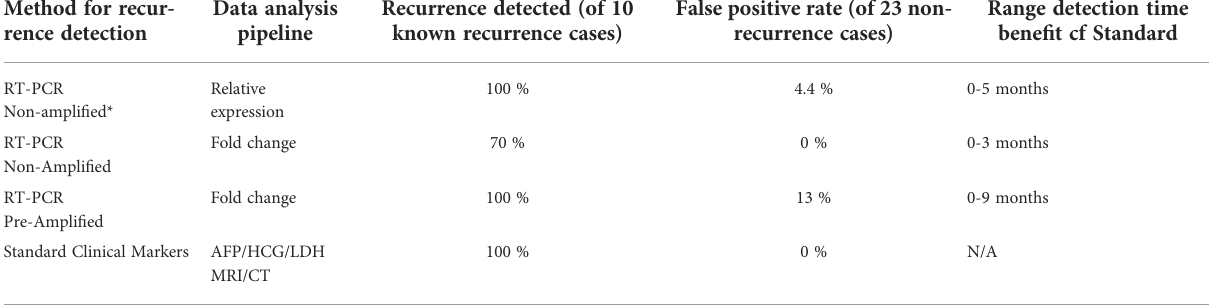
TABLE 1 Comparison of methodologies and data analysis pipelines for detection of disease recurrence in patients with Stage I TGCT. Method for recur- rence